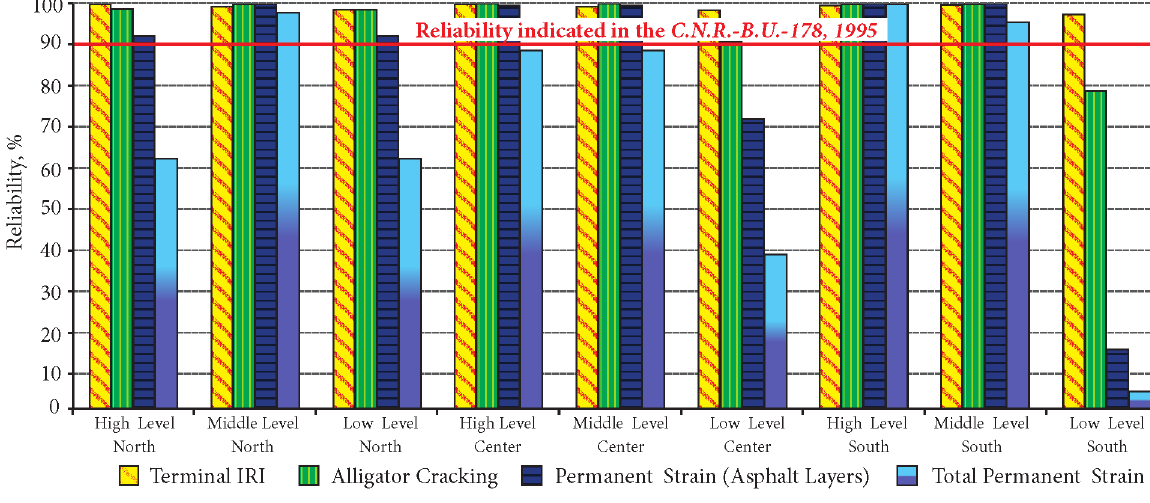
fig. 4 . Decay of the pavement – freeway/flexible pavement after 20 years